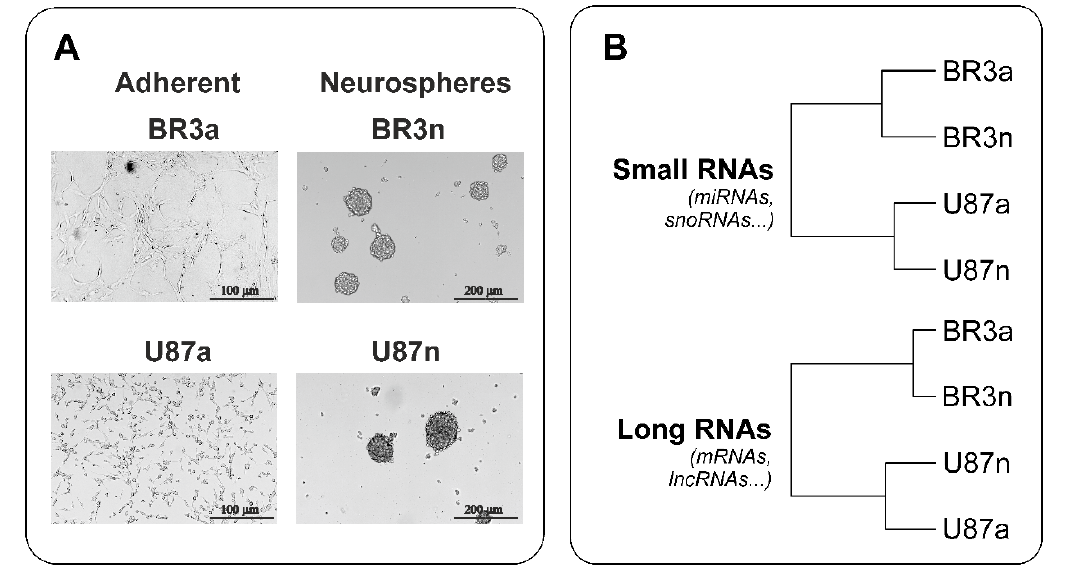
Figure 1. ( A ) Representative images of MN (“a”, adherent) and NS (“n”, neurospheres) glioblastoma cells before cell collection for NGS RNAseq analysis. ( B ) Euclidean distance trees of glioblastoma cell cultures constructed from gene expression data subjected to variation stabilizing transformation (VST). The distance trees for the small RNAs and long RNAs cDNA-libraries are shown separately. The complete agglomeration method for clustering was used.